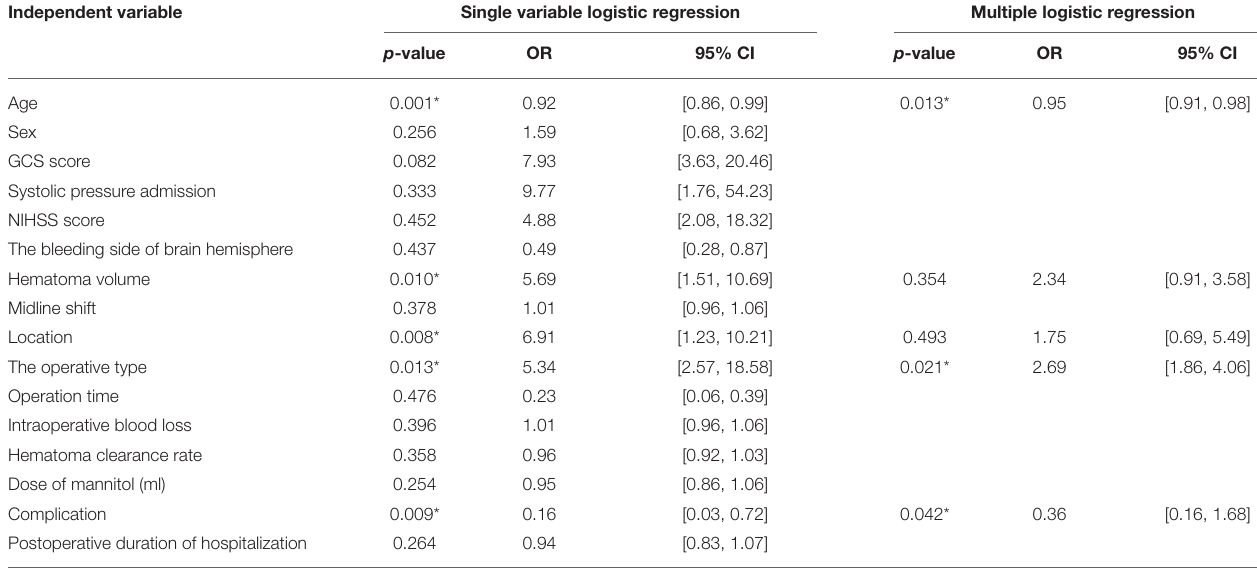
TABLE 3 | Predictors of 6-month favorable